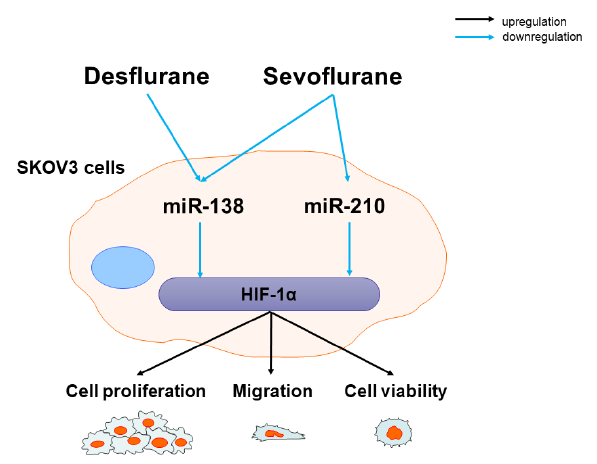
Figure 4. Inhalational anaesthetics enhanced SKOV3 cell malignancy via downregulation of anti- cancer miRNA expressions. Sevoflurane and desflurane exposure to SKOV3 cells increase SKOV3 cell proliferation and migration via HIF-1 α by miR-138 downregulation. Only sevoflurane decreased miR-210 expression leading to an enhancement of SKOV3 cell malignancy via HIF-1 α .